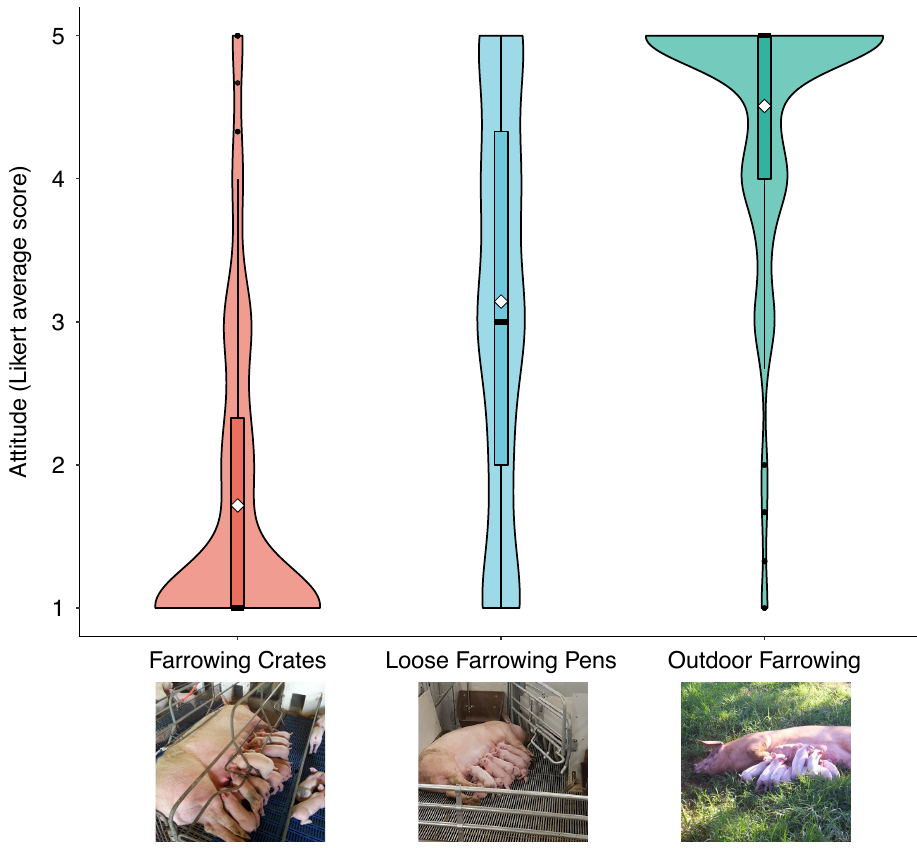
Figure 1. Violin and box plots of participants’ attitude towards three farrowing systems: farrowing crates ( n = 395), loose farrowing pens ( n = 384), and outdoor farrowing ( n = 392). Attitude score is a construct consisting of the average of three 5-point Likert scales, with higher numbers indicating a more positive attitude. The width of the violin represents the density of participants on the respective attitude score. The black dots represent outliers, the white diamonds represent the mean value, and the thickest line in the box plot represents the median